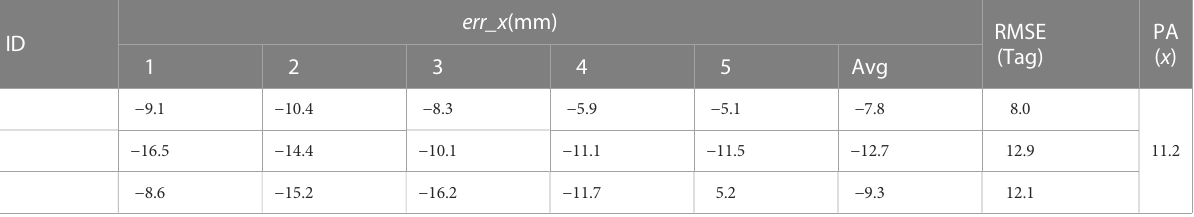
TABLE 3 Positioning accuracy in the y direction of the ATI navigation algorithm.